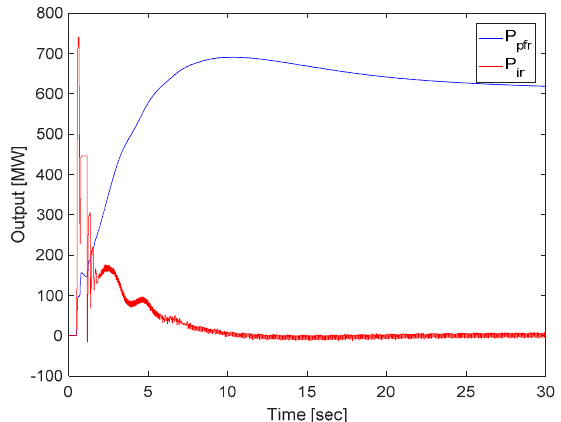
Figure 9. ESS power output element with adaptive droop.